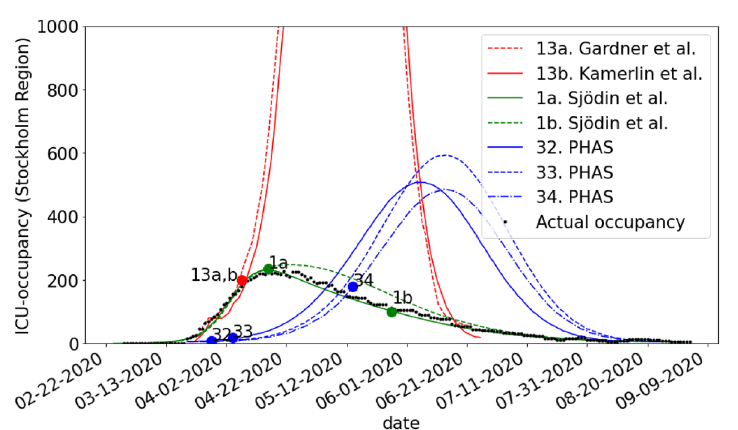
Figure 3. Predicted and actual outcome for the ICU-occupancy in Stockholm Region. The circles on the curves show the date up until which data was used in order to calibrate the model. Since PHAS did not calibrate these models using data we instead show the publication date for each report.